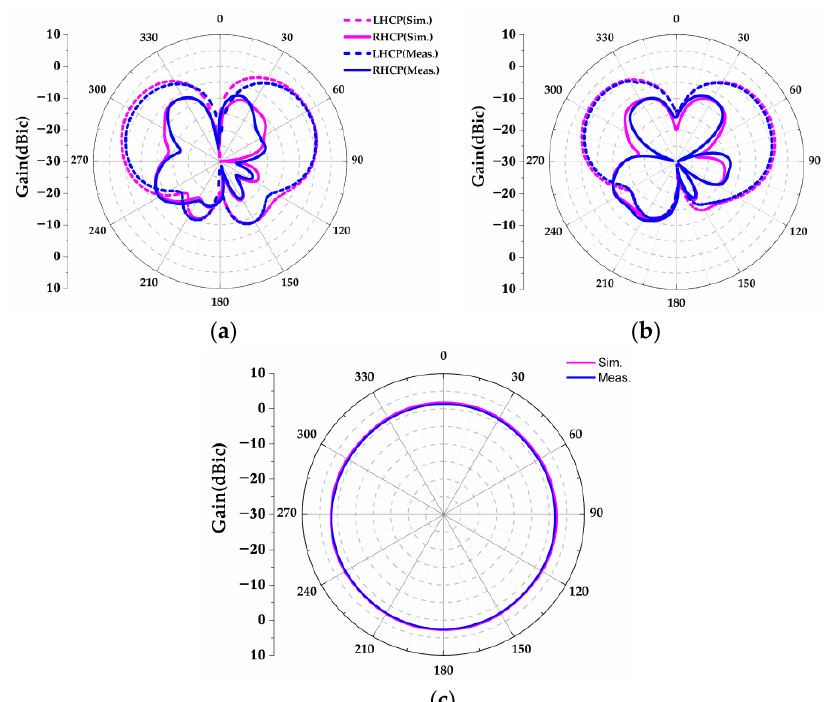
| ; ( b ) AR and gain. 11